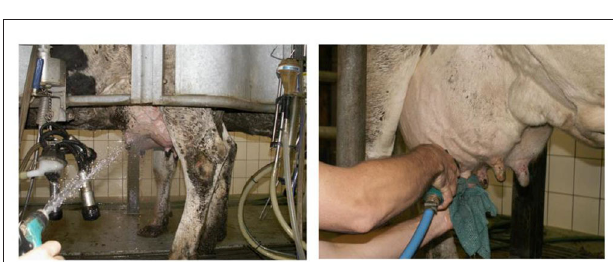
FIGURE 6 | Incorrect and correct udder washing. Note: Direct spraying with a strong stream of water on the udder is unacceptable. Slightly flowing hot water is possible to use only on contaminated teats of the udder. Source: Tanˇcin (